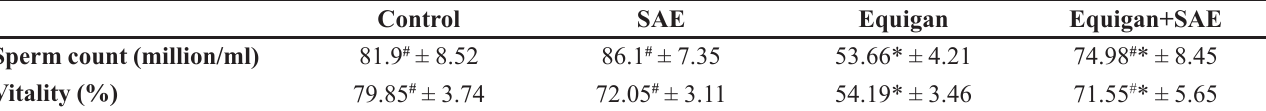
Each reading represents Mean ± SEM of 10 rats. The significance of difference was checked by t test and multiple comparison Dunnett test (compare all vs control) using a computer program graph pad (Instat software Inc). Significant difference from the control group at *p < 0.05. Significant difference from Equigan group at #p <